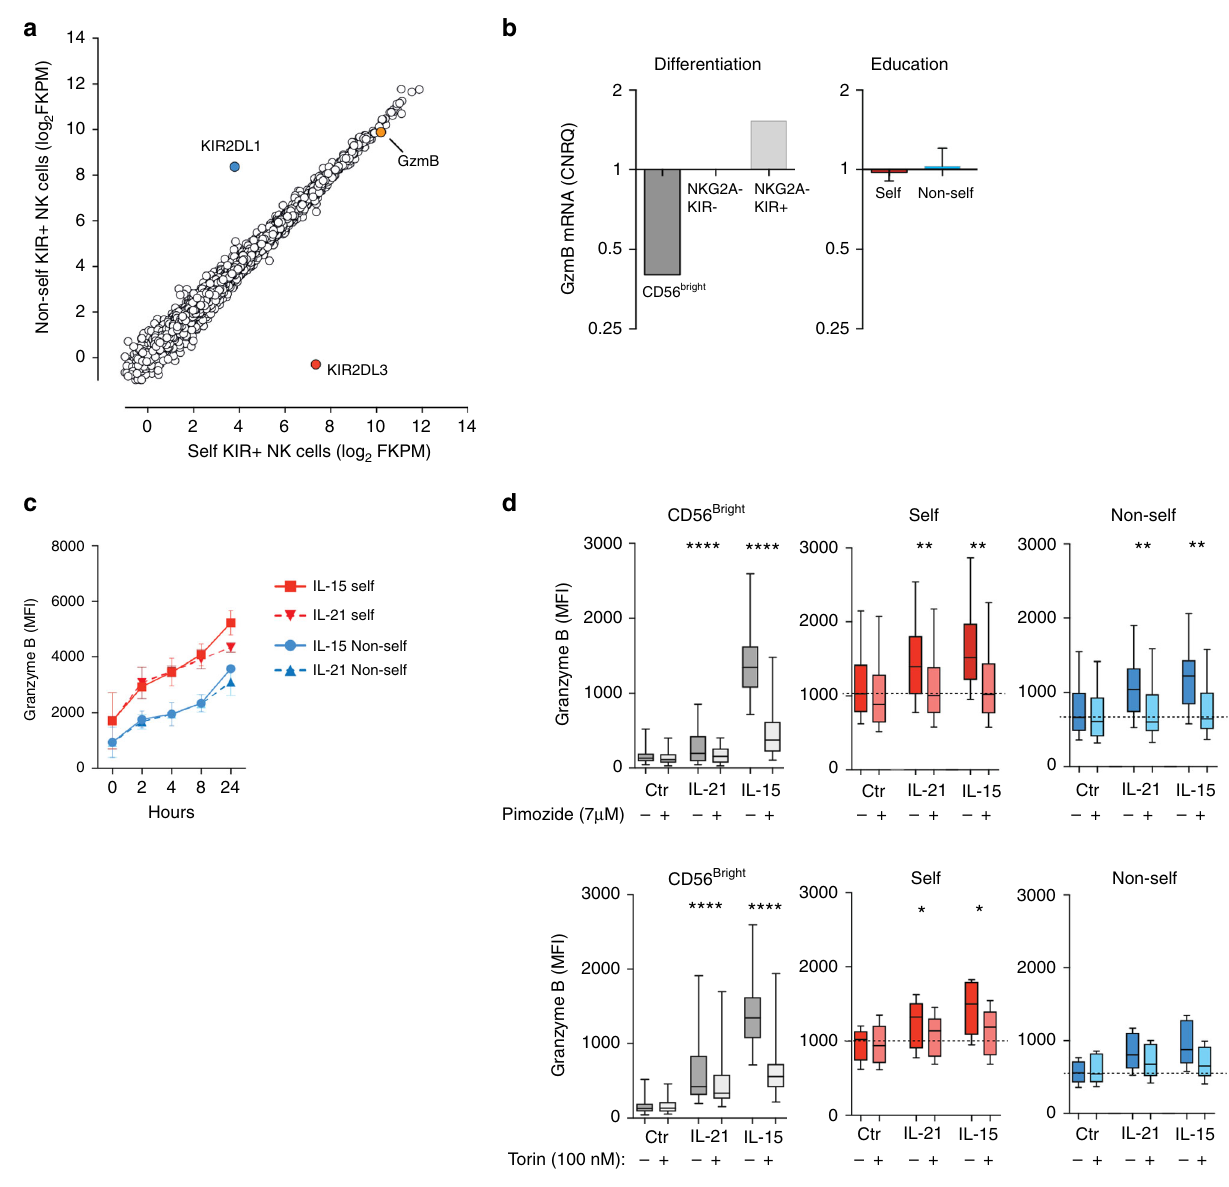
Fig. 2 Granzyme B accumulation is independent of transcription. a Global RNA-Seq of sorted self-KIR + and non-self-KIR + NKG2A − NKG2C − CD57 − NK cells. The fi gure depicts one representative C1/C1 donor out of three independent donors. b Quantitative PCR of granzyme B mRNA in sorted NK cells at different stages of differentiation (left, 4 pooled samples) and in NKG2A − NKG2C − CD57 − NK cells expressing a self- or non-self KIR (right, n = 5 paired samples). c Expression of granzyme B in the indicated NK cell subsets following stimulation with IL-15 or IL-21 for the indicated length of time (summary of two independent experiments using two different donors). d Expression of granzyme B after 24 h of stimulation with IL-21 or IL-15 in CD56 bright NK cells and NKG2A − NKG2C − CD57 − single-positive CD56 dim NK cells expressing a self- or non-self KIR NK cell subset in the presence or absence of the STAT-5 inhibitor Pimozide (top) (7 μ M) and the mTOR inhibitor Torin-1 (100 nM) (bottom). The data in panel ( d ) are the summary of at least two independent experiments. Whiskers show 5th to 95th percentile. Bars show the median. Wilcoxon paired, non-parametric tests. **** p < 0.0001 and ** p < 0.01. Red and blue circles, connecting lines and box plots represent NK cells with self or non-self KIR,